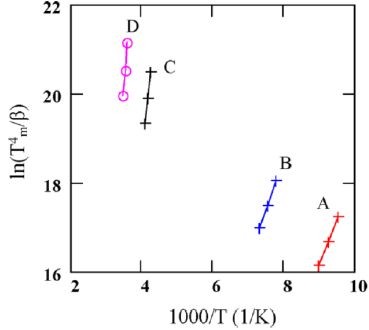
Figure 18. TSC spectra obtained using a SI 4H-SiC (SI-M50) epitaxial layer for three different heating rates.